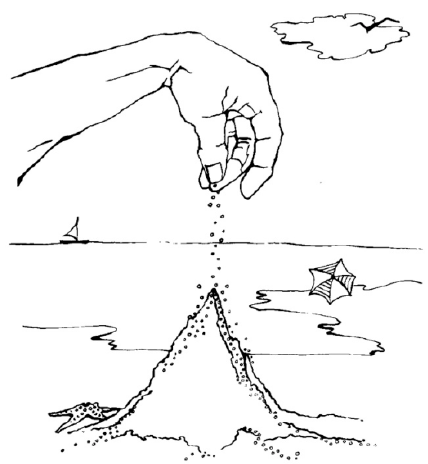
Figure 1. A pictorial representation of the SOC (sandpile model): the grains are gently added grain by grain to the sandpile (continuous small perturbations from the microenvironment), provoking small avalanches that keep invariant the sandpile slope (homeostasis). Occasionally, by a sort of domino effect, when avalanches cooperate, the core of the sandpile is affected and the sandpile goes down (cell ‐ fate transition).